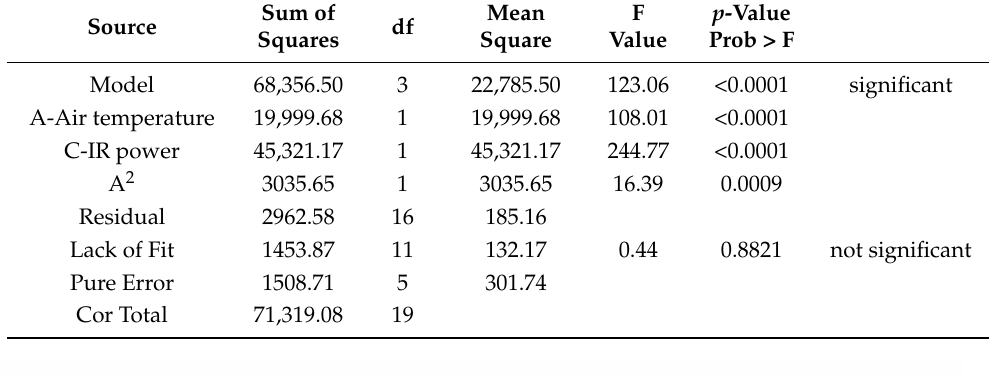
Table 10. Analysis of variance for TPC response using RSM.